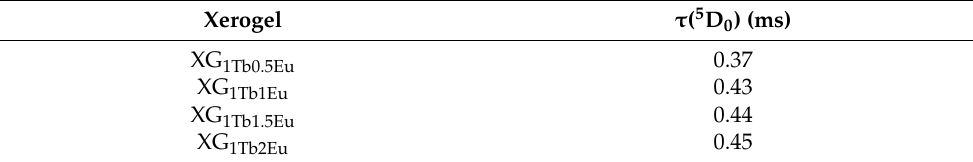
Figure 14. Luminescence decay curves of the 5 D 0 state of Eu 3+ ions recorded for: ( a ) xerogels ( λ exc = 395) and ( b ) glass- ceramics ( λ exc = 394 nm). Table 3. Measured lifetimes of the 5 D 0 state (Eu 3+ ) in xerogels ( λ exc = 395 nm